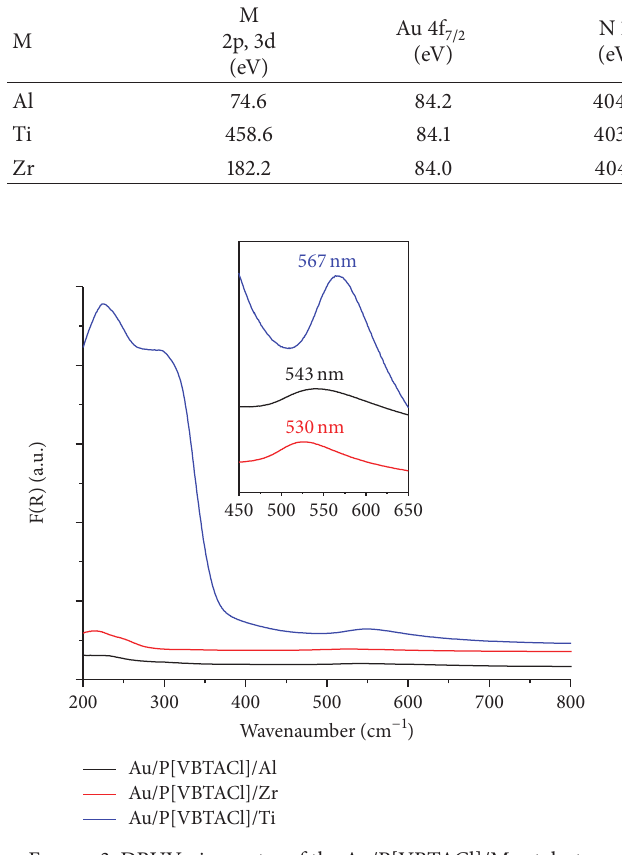
with TEM and XRD characterization previously reported by Campos et al. [40].